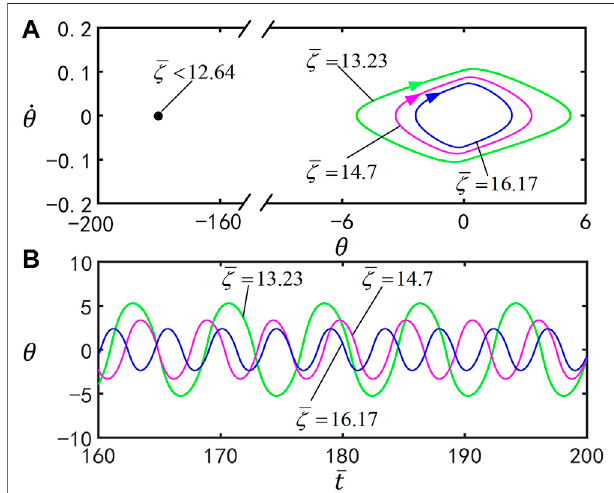
FIGURE 8 | Effect of the damping coef fi cient (cid:2) ζ on the self-stabilized oscillation of the inverted pendulum for (cid:2) I (cid:2) 0 . 25, C 0 (cid:2) 0 . 4, (cid:2) g (cid:2) 9 . 8, θ 0 (cid:2) 0 ° , θ (cid:2) 70 ° ,and _ θ (cid:2) 0. (A) Limitcyclefor (cid:2) ζ (cid:2) 13 . 23, (cid:2) ζ (cid:2) 14 . 7,and (cid:2) ζ (cid:2) 16 . 17. (B) 1 0 Time series for (cid:2) ζ (cid:2) 13 . 23, (cid:2) ζ (cid:2) 14 . 7, and (cid:2) ζ (cid:2) 16 . 17. The amplitude and period of self-stabilized oscillation decrease by increasing (cid:2) ζ .